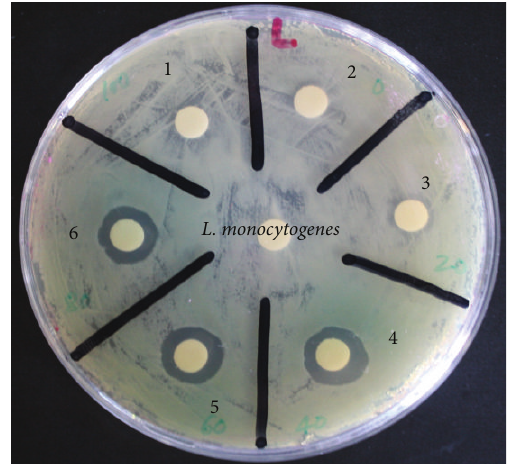
Figure 3: Antimicrobial activity of standard (fucoxanthin), crude extract, and purified compound against L. monocytogenes bacteria (control (1, 2, and 3); standard (4); purified compound (5); crude extract